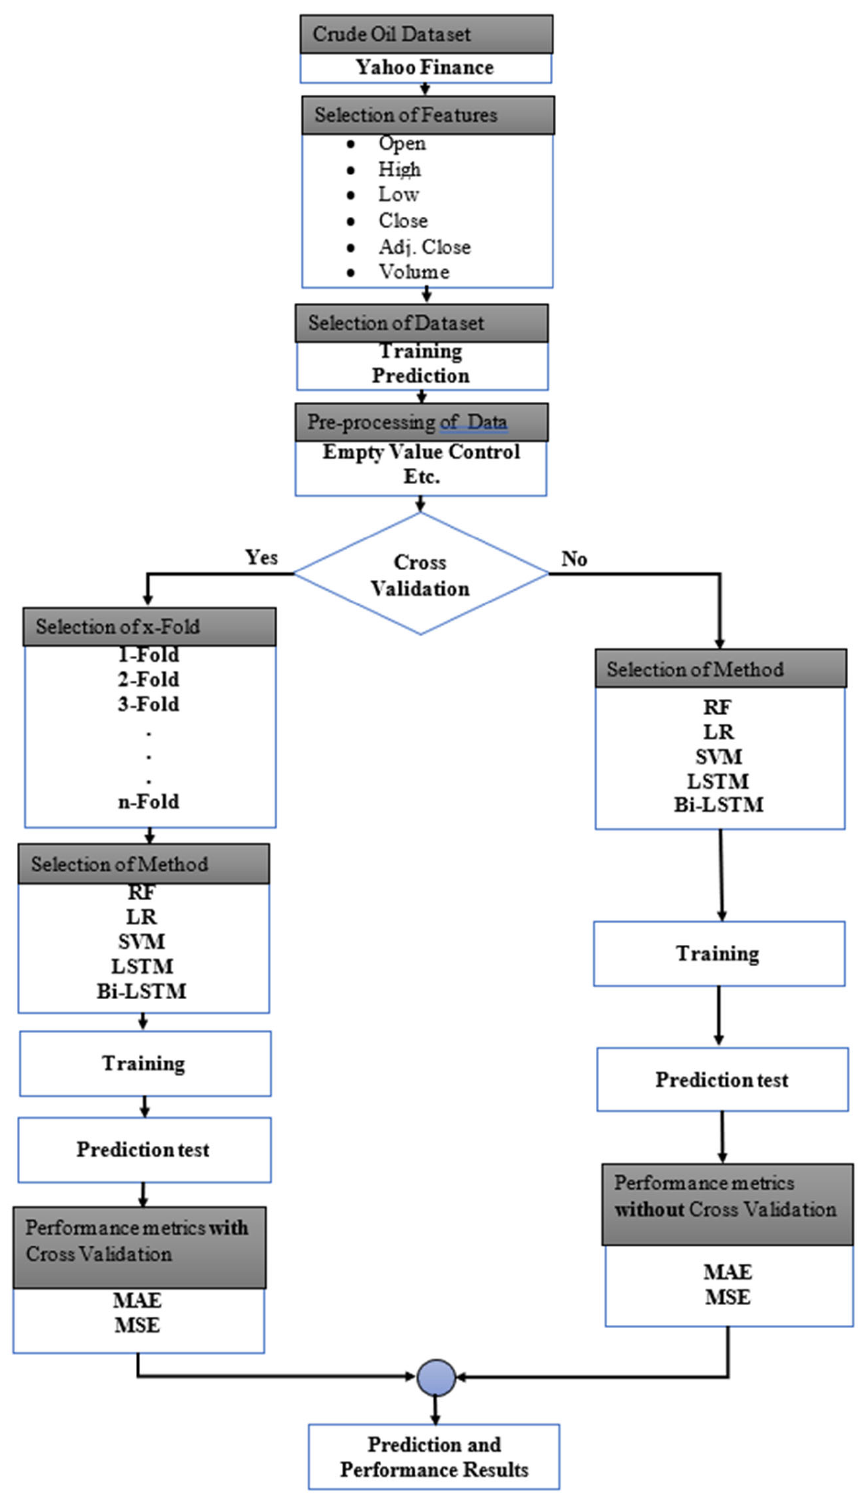
Figure 3. Flowchart of the proposed method.